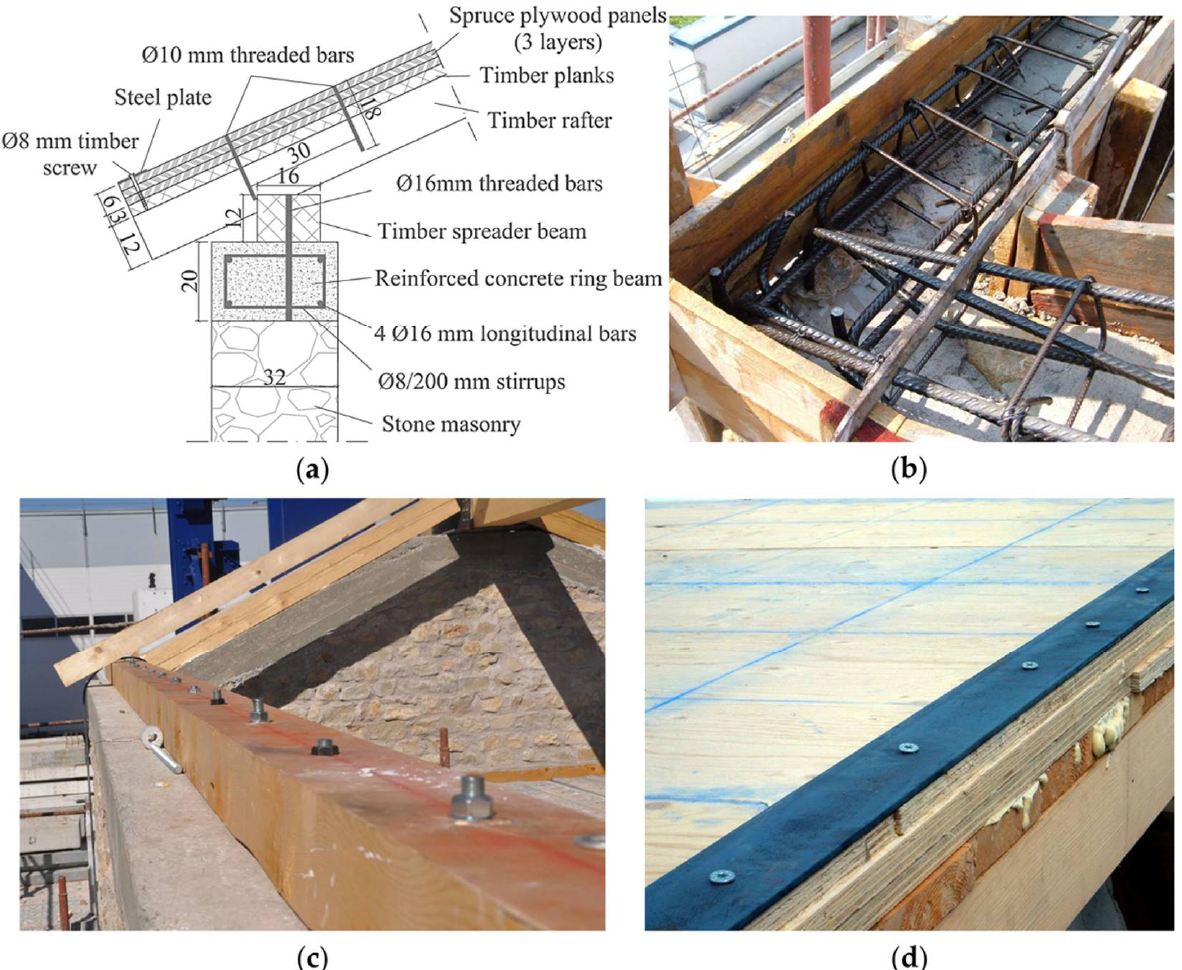
Figure 9. Building 3, retrofit at the roof level: ( a ) structural detail of the RC ring beam; ( b ) ring beam reinforcement at corner; ( c ) timber spreader beam connected to the RC ring beam above a longitudinal wall; ( d ) spruce plywood layers and continuous steel plate along the perimeter. Units of cm.